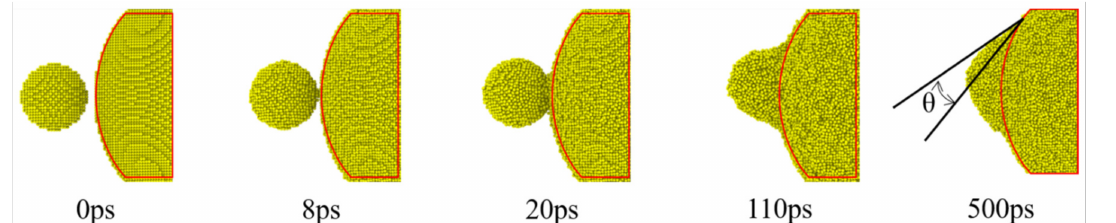
Figure 13. The sintering angle ( θ ), which is defined as the angle between the tangential line of the melting small-sized nanoparticle liquid surface and the tangential line of the rigid large-sized nanoparticle solid surface, forms and grows during the sintering process. The red line is the edge of large-sized